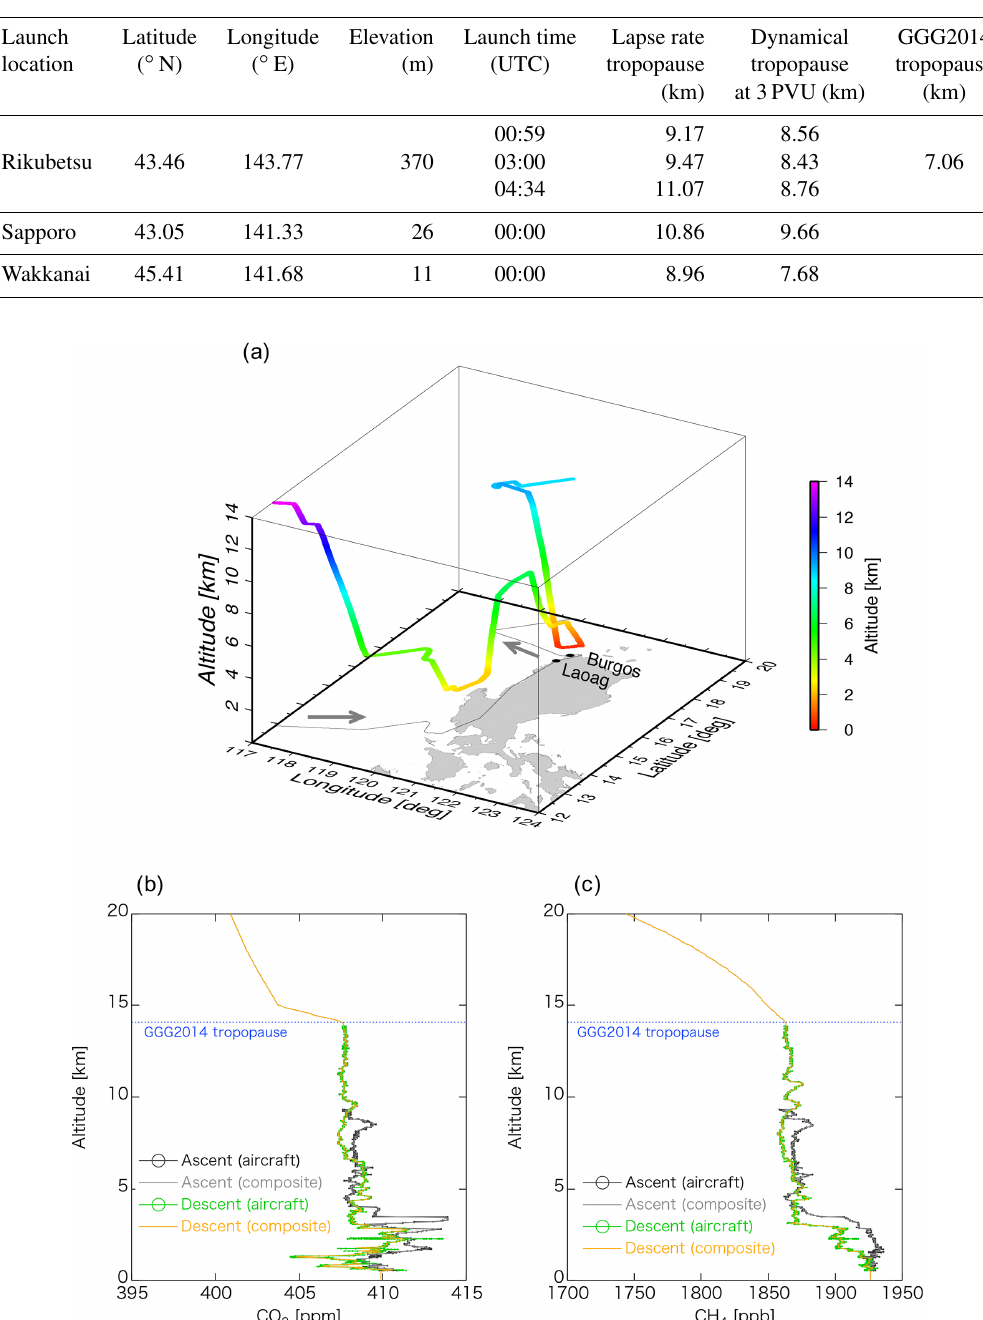
Table 1. Summary of radiosonde observations in Hokkaido, Japan, on 27 April 2016. The last two columns show the dynamical tropopause from the ERA5 potential vorticity values and the GGG2014-derived tropopause.